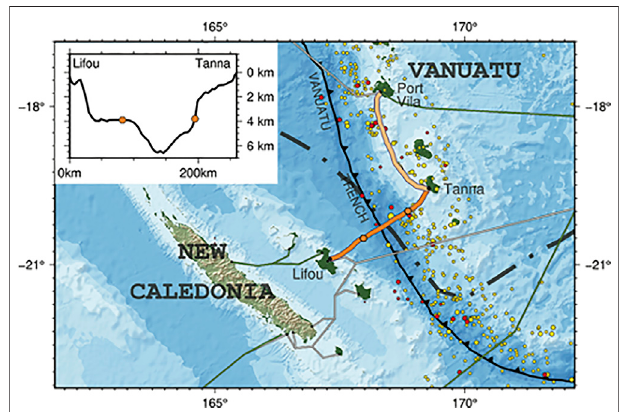
FIGURE 10 | Proposed SMART cable connecting Vanuatu and New Caledonia,withaSMARTrepeateroneachsideoftheVanuatu/NewHebrides